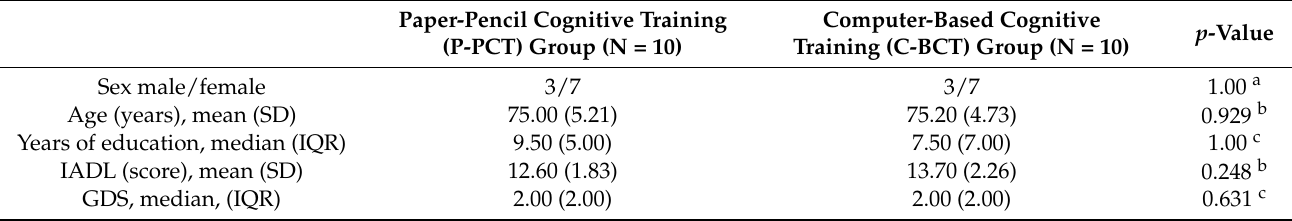
Table 1. Demographic characteristics of the participants.